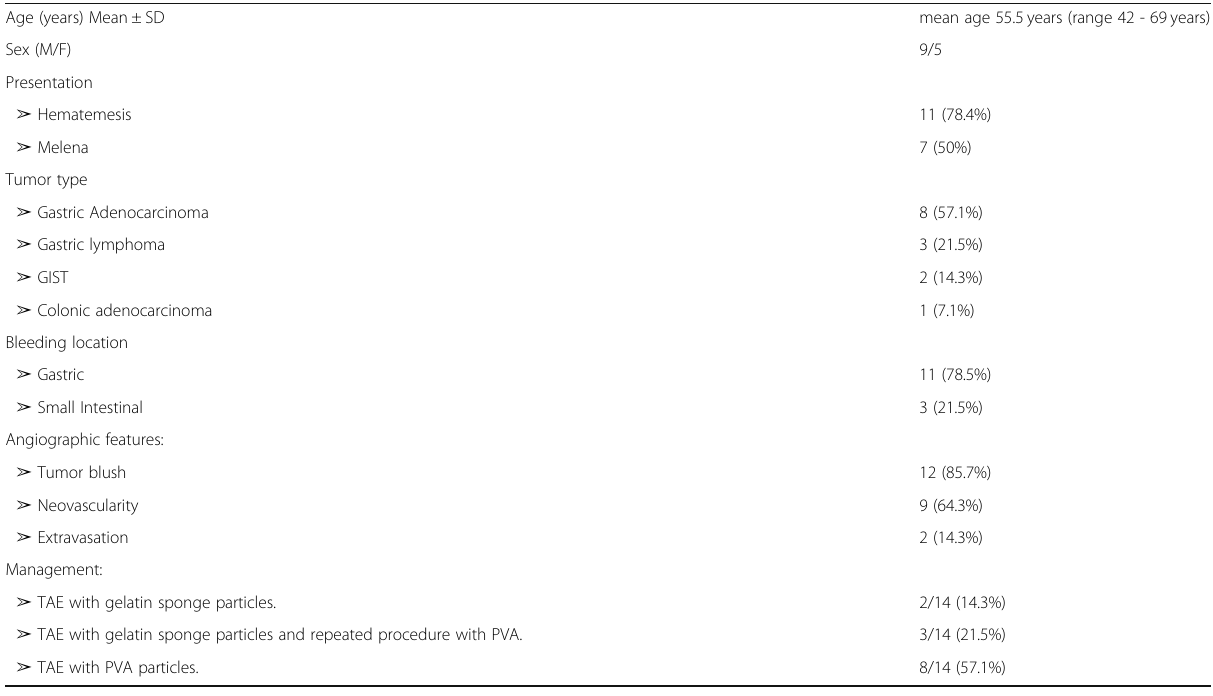
Table 1 Baseline demographics, presentations, tumor type, location, angiographic features, and management Age (years)